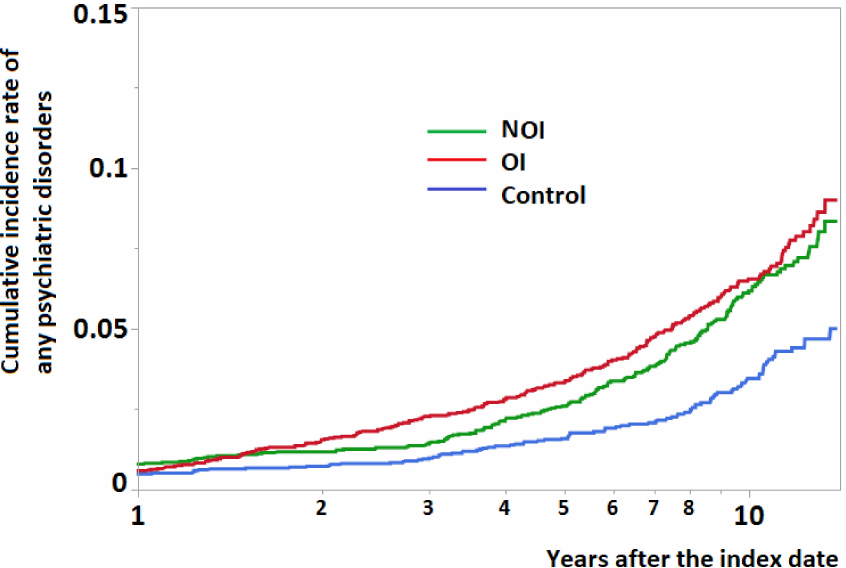
Figure 2. Cumulative incidence rate of any psychiatric disorders in di ff erent study